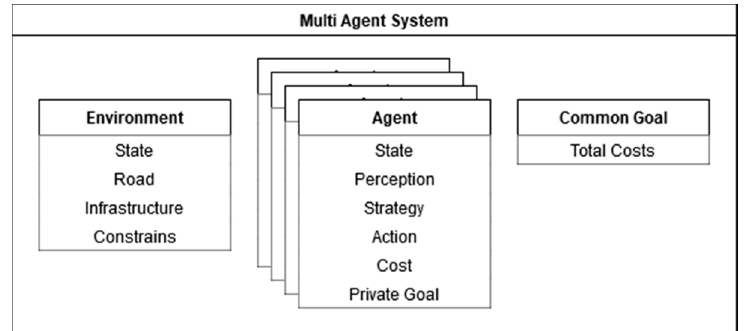
Figure 1. Overview of an multi-agent system with four agents in a shared environment working towards a common goal.